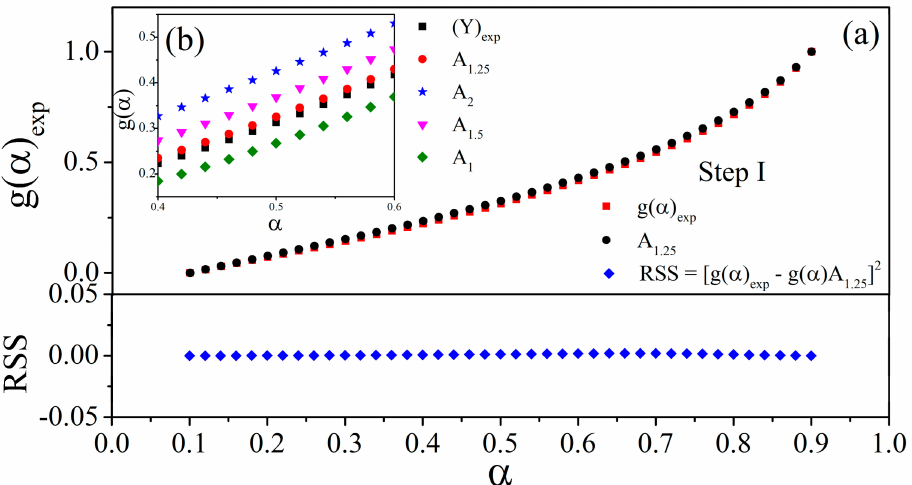
Figure 9. The experimental and the theoretical plots ( a , b ) of the explored g( α ) versus α curves using the reaction models for the first step.